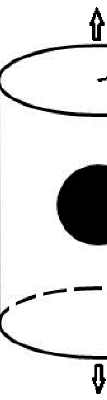
Figure 2. The DP steel cell.